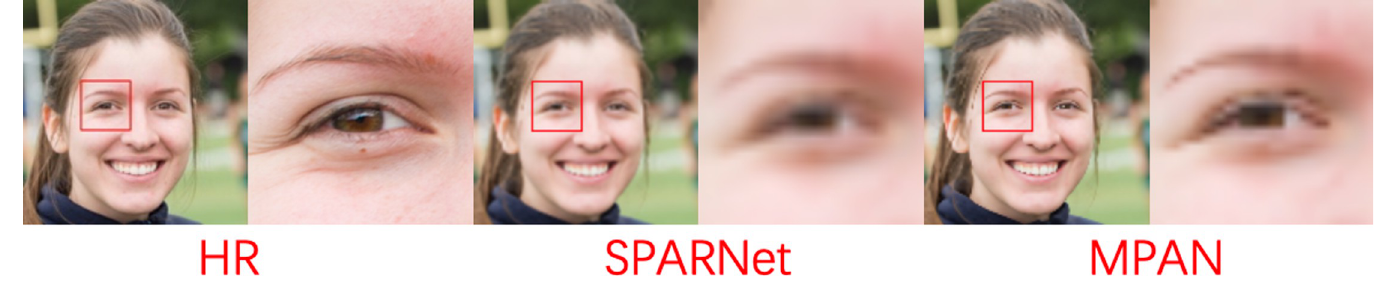
Fig 8. Comparative results of MPAN and SPARNet for 2X SR.